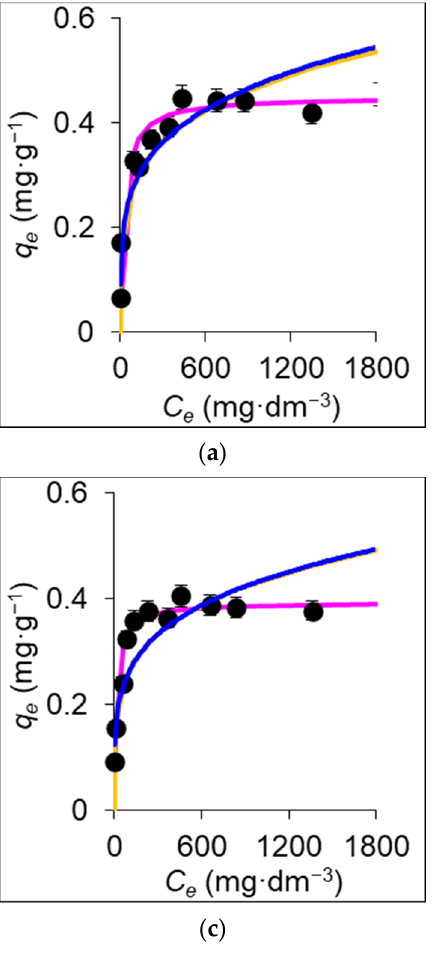
Figure 1. Experimental data of Cu sorption on Z-M20 from ( a ) CuSO 4 ( b ) Cu(NO 3 ) 2 , and Zn sorption on Z-M20 from ( c ) ZnSO 4 ( d ) Zn(NO 3 ) 2 . Note: black dots—experimental data ± standard deviation; blue line—Freundlich isotherm, pink line—Langmuir isotherm, orange line—Redlich–Peterson iso- therm.